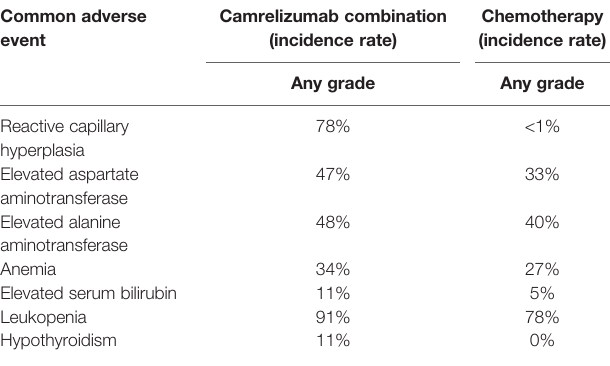
TABLE 3 | Comparison of the incidence of common adverse events (any grade) between camrelizumab combination and